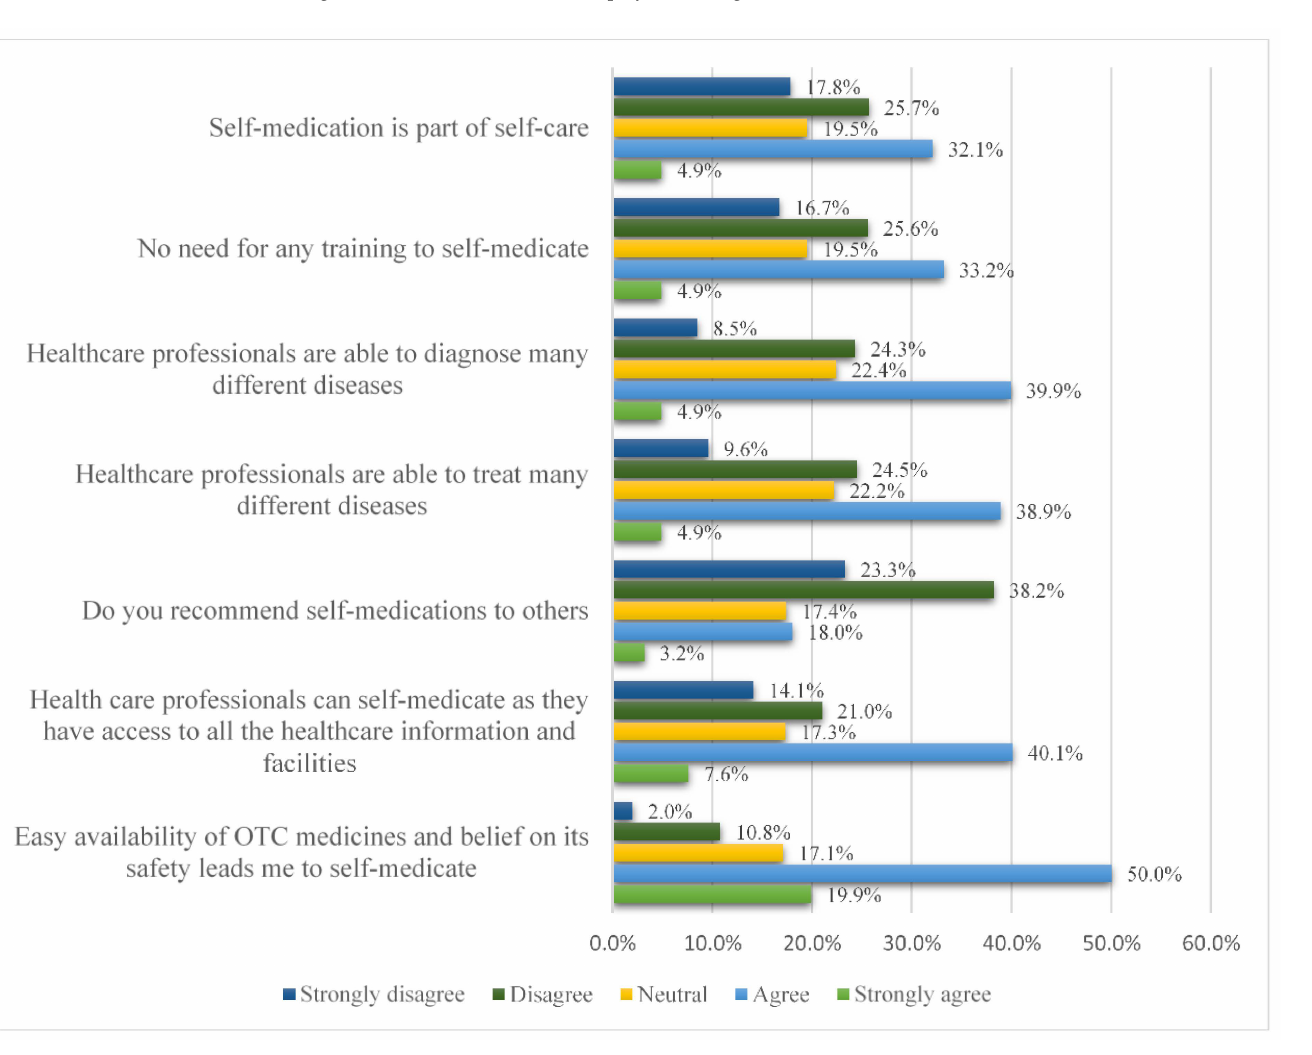
Figure 2. Healthcare workers’ attitudes towards self-medication. NB: N =